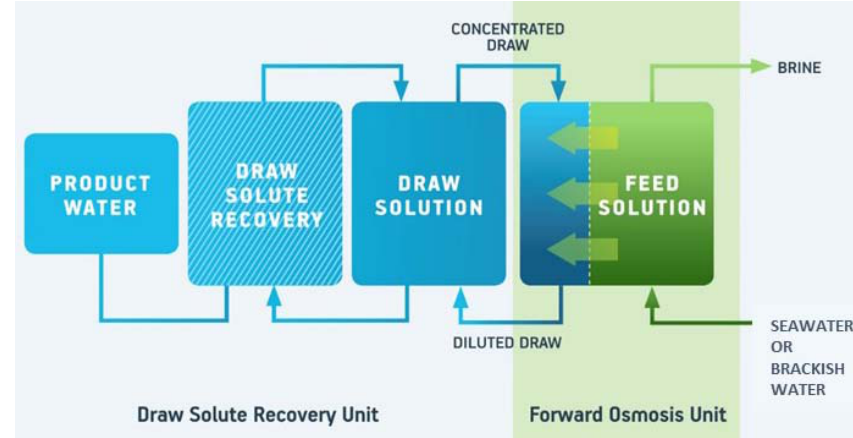
Figure 6. FO process for desalination of seawater/brackish